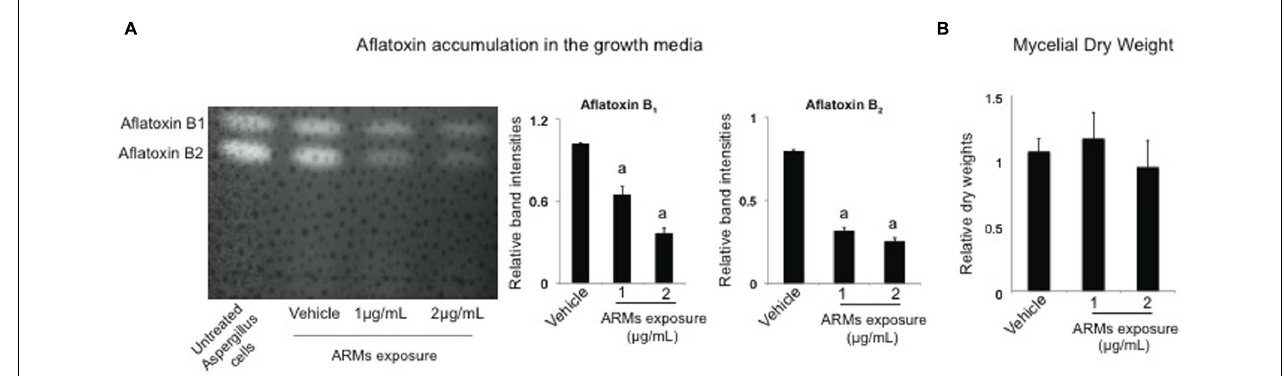
FIGURE 4 | Effect of ARMs on aflatoxin biosynthesis and fungal growth. (A) Effect on aflatoxin accumulation in the growth media. Left panel, a representative TLC plate providing a qualitative comparison of aflatoxin accumulation in the untreated culture and cultures that were supplemented with 1 and 2 µ g/mL ARMs extract and the vehicle (DMSO). Right panel, semi-quantitative comparative comparisons of band intensities of aflatoxin B 1 and aflatoxin B 2 . a, significant difference in band intensity compared to the vehicle control. (B) Effect on growth. Comparison of dry-weight measurements. Bars represent measurements relative to the dry-weight of untreated cells. Statistical significance of two-tailed p -values were determined using an unpaired t -test, with sample size of n = 3 and p < 0.05 set as level of significance.